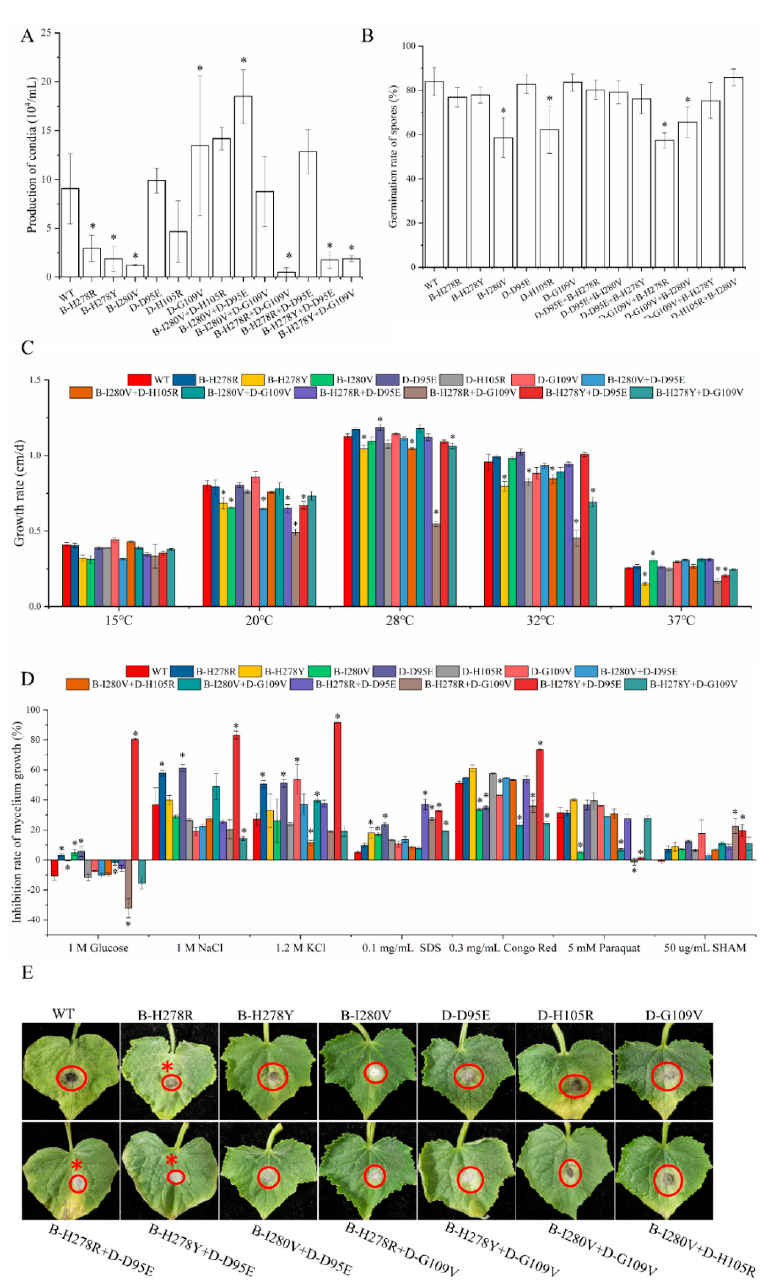
Figure 4. Analysis of fitness components among the double and single mutation isolate. * Indicates significant differences compared with WT ( p < 0.05). ( A ) Conidial production of the double and single mutation isolate. Strains were cultured on PDA medium under continuous dark conditions for 10 days. ( B ) Germination rates of the double and single mutation strain after 4–6 h of incubation in 0.1% Tween 20 medium at 28 ◦ C. ( C ) Mycelial growth rate of C. corynespora mutants at different temperatures. Mycelial growth was measured at 28 ◦ C on 90-mm-diameter Petri dishes containing 20 mL of PDA medium. ( D ) Environment stresses include osmotic (generated by 1 M of glucose, 1 M of NaCl, and 1.2 M of KCl), oxidative stress (generated by 5 mM of paraquat), cell wall damage (generated by 0.03 mg mL − 1 of Congo Red and 0.1 mg mL − 1 of SDS) and salicylhydroxamic acid (SHAM; generated by 50 µ g mL − 1 of SHAM). After 9 days of incubation at 28 ◦ C, the percentage inhibition of mycelial radial growth (PIMG) was calculated. ( E ) Pathogenicity of the double and single mutation strains in the absence of fungicide treatment. Pathogenicity was analyzed after 5 days of incubation at 28 ◦